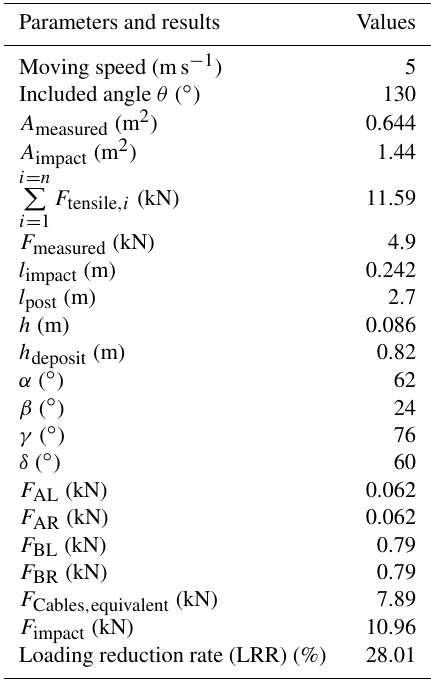
Table 2. Values of measured parameters and calculated results in test